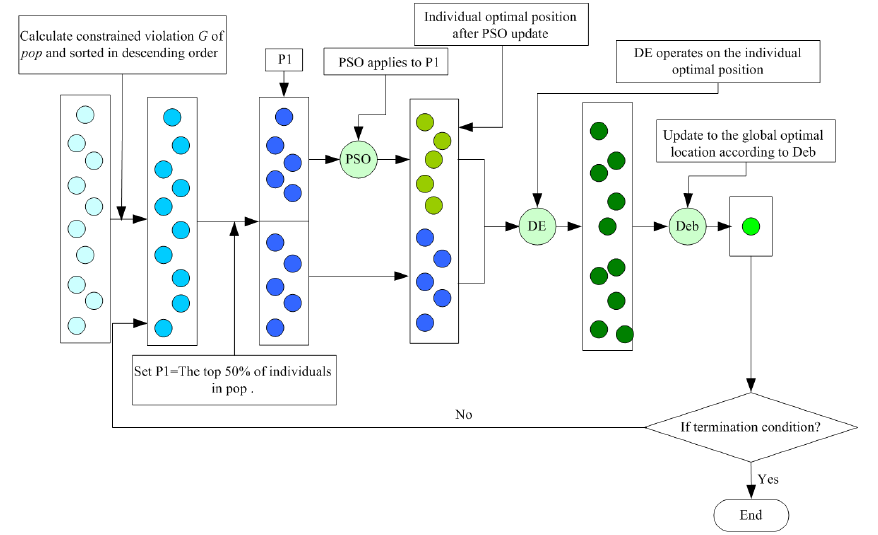
Figure 5. The flow chart of